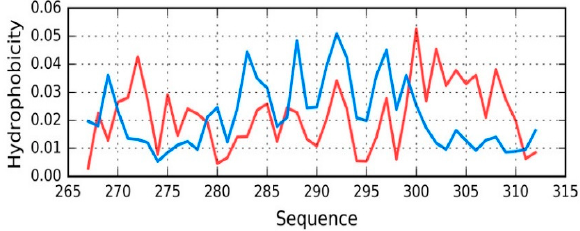
Figure 7. T (blue) and O (red) hydrophobicity distributions in Tau (267–312) (2MZ7), revealing overall strong discordance.